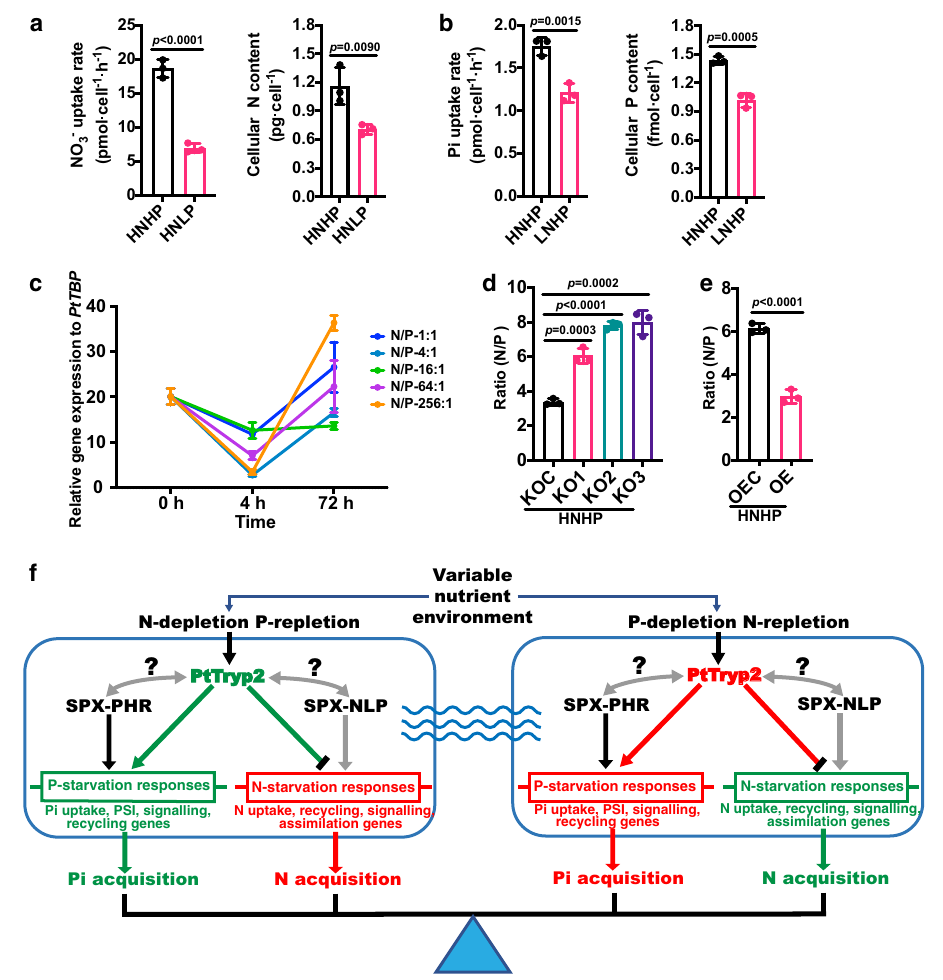
Fig. 7 Illustration that PtTryp2 coordinately regulates N and P acquisition under fl uctuating nutritional conditions. a NO 3 − uptake and cellular N content repressed under HNLP in wild-type cells (WT). Data are presented as mean values ± SD ( n = 3 biologically independent samples). The comparisons between the averages of the two groups were evaluated using the one-tailed Student ’ s t test. The p values with signi fi cance ( p ≤ 0.05) are shown. b Pi uptake and cellular P content repressed under LNHP in wild-type cells (WT). Data are presented as mean values± SD ( n = 3 biologically independent samples). The comparisons between the averages of the two groups were evaluated using the one-tailed Student ’ s t test. The p values with signi fi cance ( p ≤ 0.05) are shown. c Time-course expression of PtTryp2 showed co-varied with the N/P nutrient ratio. Moreover, PtTryp2 expression fl uctuated less at the N/P ratio of 16:1 compared to other N/P ratios. The 4 h after nutrient addition represents nutrient-repletion and 72 h nutrient- depletion. Data are presented as mean values± SD ( n = 3 biologically independent samples). d The cellular N/P ratio was signi fi cantly elevated by the inactivation of PtTryp2 . Data are presented as mean values ± SD ( n = 3 biologically independent samples). The comparisons between the averages of the two groups were evaluated using the one-tailed Student ’ s t test. The p values with signi fi cance ( p ≤ 0.05) are shown. e The cellular N/P ratio was signi fi cantly decreased by the overexpression of PtTryp2 . Data are presented as mean values ± SD ( n = 3 biologically independent samples). The comparisons between the averages of the two groups were evaluated using the one-tailed Student ’ s t test. The p values with signi fi cance ( p ≤ 0.05) are shown. f Hypothetical model depicting the role of PtTryp2 in balancing N and P acquisition. Under N-depletion, PtTryp2 expression is downregulated to promote N-starvation responses and repress P-starvation responses. In contrast, under P-depletion, PtTryp2 expression is upregulated to reinforce P-starvation responses and lessen N-starvation response. By this feedback loop, optimal N-P uptake is achieved to maintain stoichiometric homeostasis. Upregulated genes and enhancement processes are shown in red, downregulated genes and weakened processes colored green. The black arrows depict transcriptional activation. Black bar at line ’ s end depicts inhibitory regulation. The gray arrows depict possible but unveri fi ed interaction between PtTryp2 and the existing P regulating cascade SPX-PHR or an equivalent of the N regulating cascade known in plants ( SPX-NLP where NLP stands for NIN-like protein, a transcription factor). Source data are provided as a Source Data fi